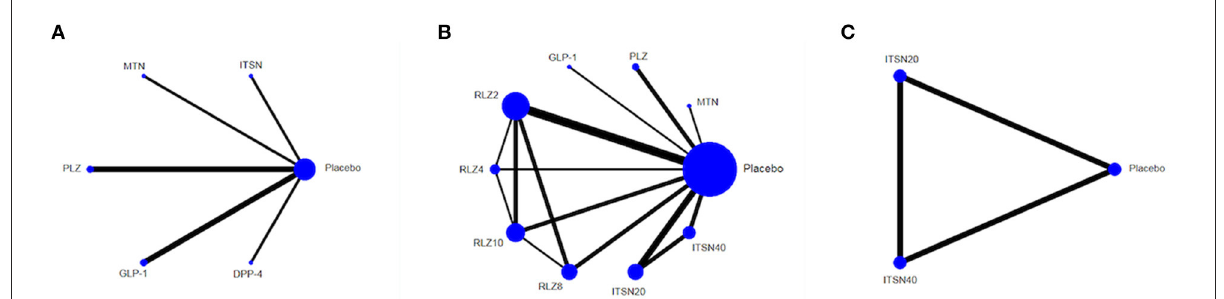
FIGURE3 Network map for hypoglycemic drugs (HD) with placebo in improving MMSE score. (A) ADAS-Cog score, (B) ADCS-ADL scale score, (C) Lines connect the interventions that have been studied in head-to-head comparisons in eligible RCTs. The width of the lines represents the total number of RCTs for each pairwise comparison. The size of each node is proportional to the number of randomized participants. Metformin (MTN), Pioglitazone (PLZ), Intranasal insulin 20 IU (ITSN20), Intranasal insulin 40 IU (ITSN40), Rosiglitazone 2mg (RLZ2), Rosiglitazone 4mg